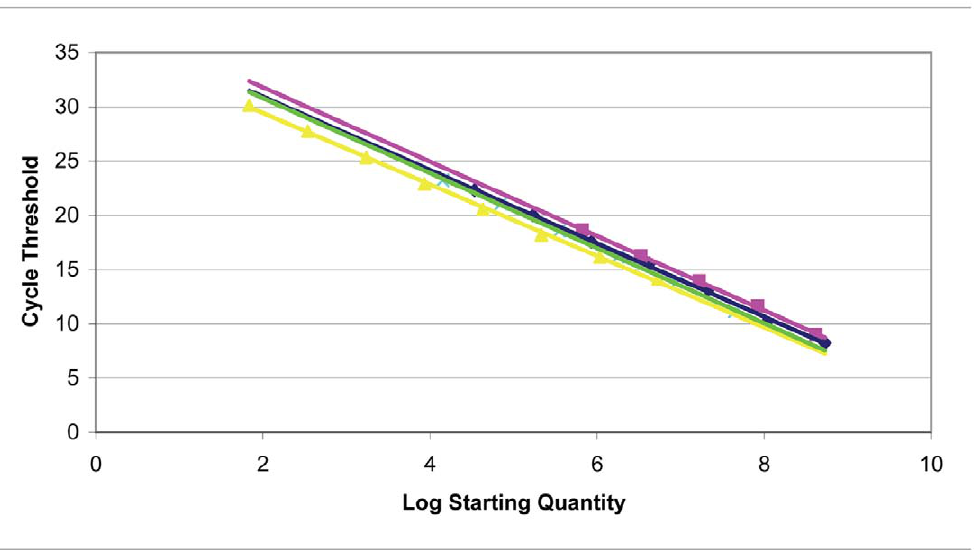
Figure 2. Standard curve used to quantify plasmid copy number in E.coli. Plasmid standard curves were generated using known amounts of plasmid DNA. The linear dynamic range was determined to be from 5.37 6 10 6 to 69 copies of genomic DNA (yellow), 4.40 6 10 7 to 1.41 6 10 4 copies of pSAM (green), 4.18 6 10 8 to 6.69 6 10 5 copies of pACYC (pink), and 5.32 6 10 8 to 3.41 6 10 4 copies of pGEX-6p-1 (blue). Regression analysis displayed R 2 values of 0.999 for pSAM, 0.998 for pGEX-6p-1, 0.998 for pACYCDuet, and 0.999 for genomic DNA.